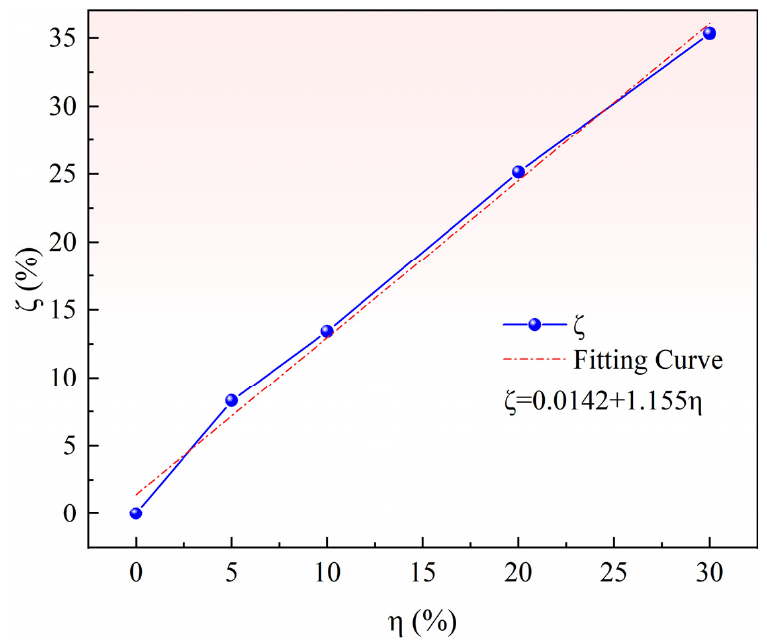
Figure 5. Relationship between the porosity and dosage of pore-forming agent.